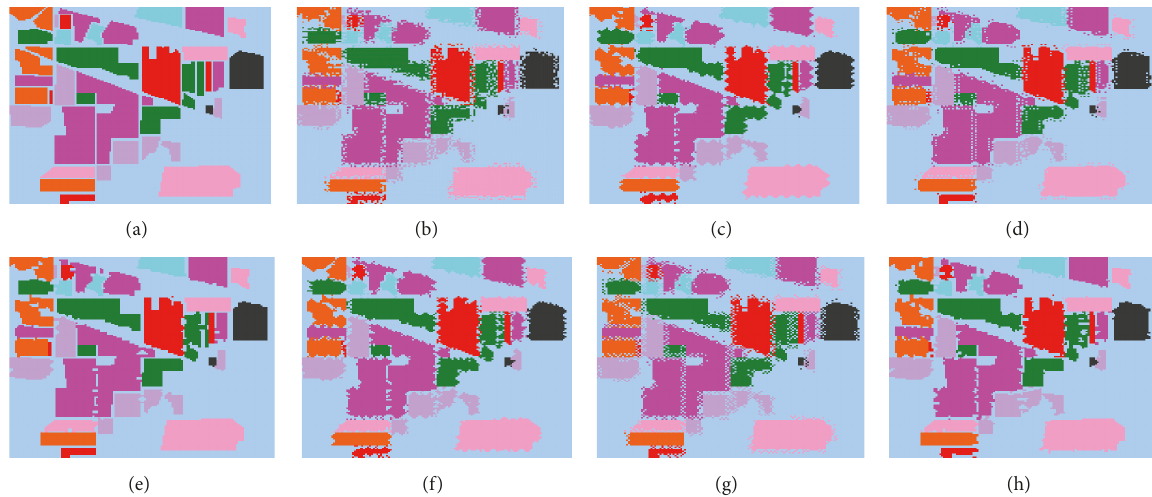
Figure 8: Subpixel positioning results of six algorithms for Figure 4(a): (a) true distribution, (b) random distribution, (c) PMBQPSO, (d) CMBQPSO, (e) GMBQPSO, (f) PBQPSO, (g) CBQPSO, and (h) GBQPSO.